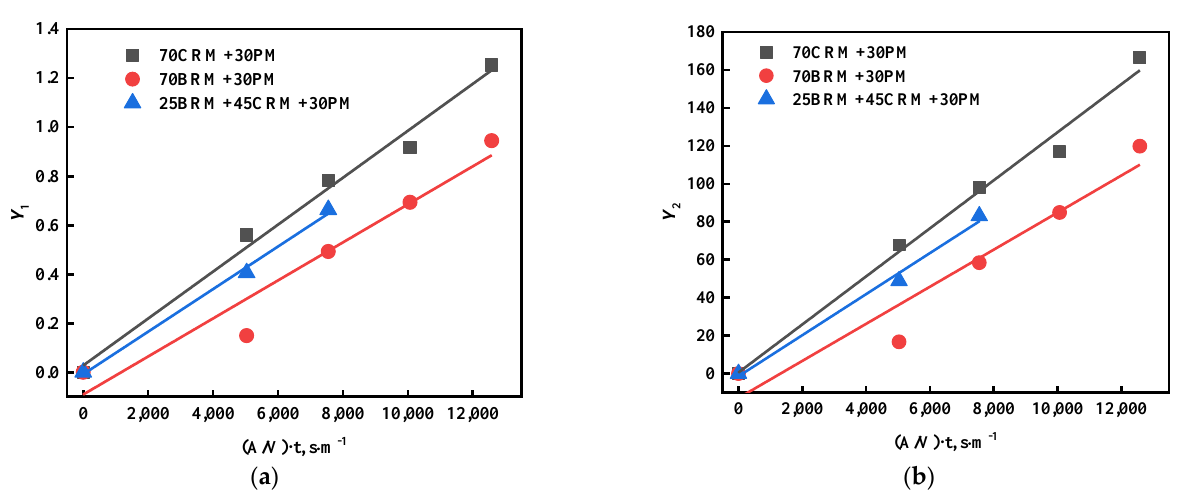
Figure 7. Data fitting of denitrification ratio: ( a ) the first order reaction model and ( b ) the second-order reaction model. Table 5. R2 and Reaction rate k Reaction Order Raw Material R 2 First-order reaction